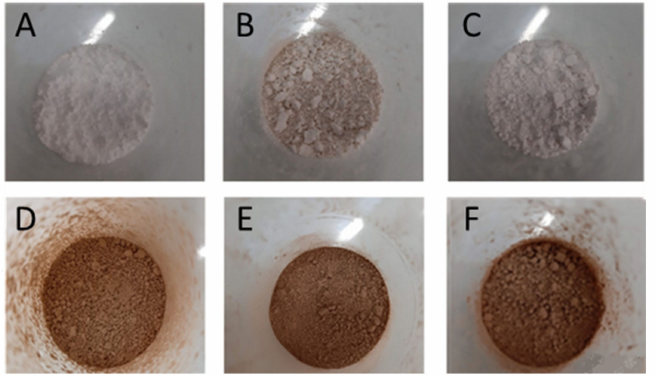
Figure 1. Visual aspect of the powders obtained after atomization in Mini Spray-dryer Buchi B-290 of wall materials alone: maltodextrin ( A ), soy protein ( B ), starch ( C ). Powders obtained after atomization of wall materials together with MAE are presented on the second line: maltodextrin + MAE ( D ), soy protein + MAE ( E ), and starch + MAE ( F ).